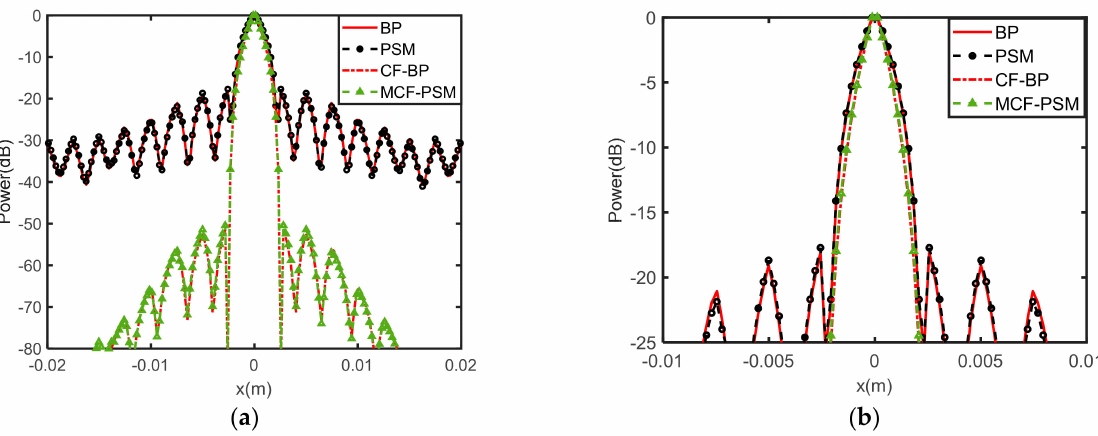
Figure 9. The 1D profile along x-axis of the center point. ( a ) 1D Profile under − 80 dB dynamic range. ( b ) Zoomed-in display near the main